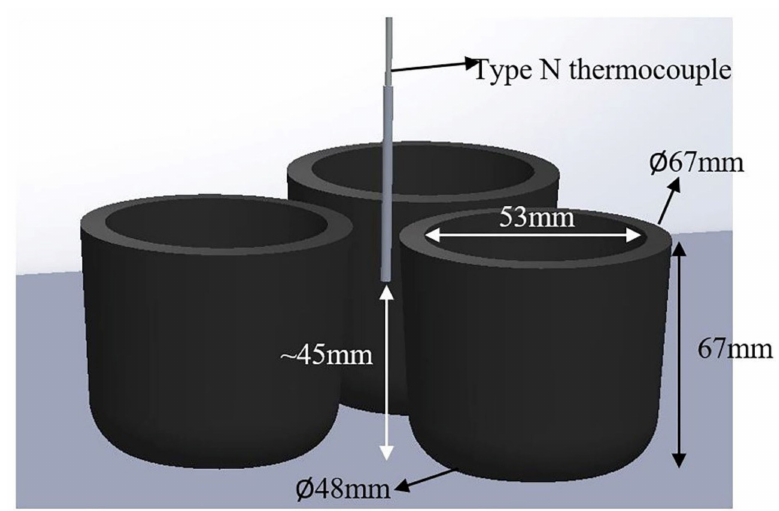
Figure 1. Experimental setup used for the isothermal holding treatments.